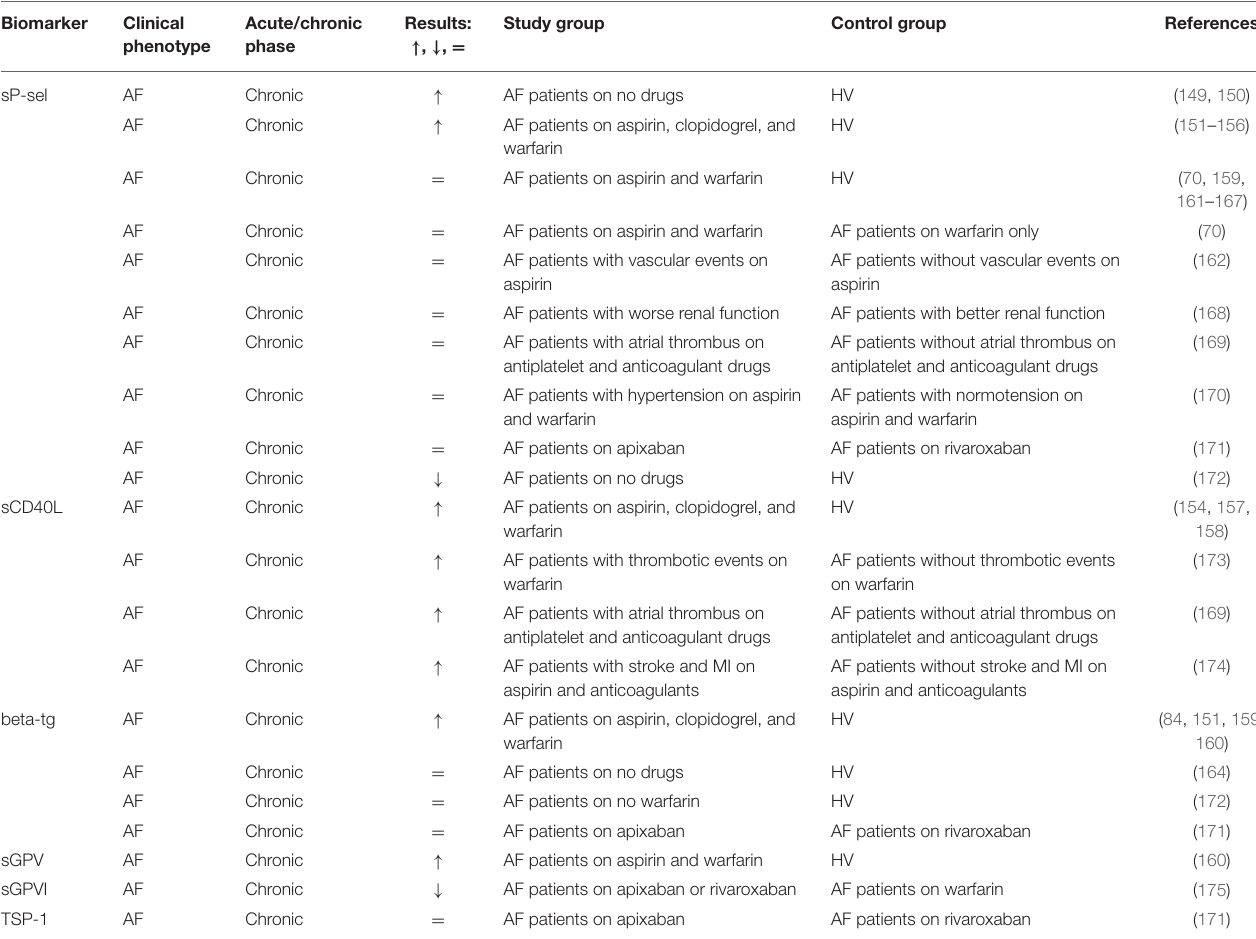
TABLE 5 | Soluble biomarkers of platelet activation in atrial fibrillation (AF)